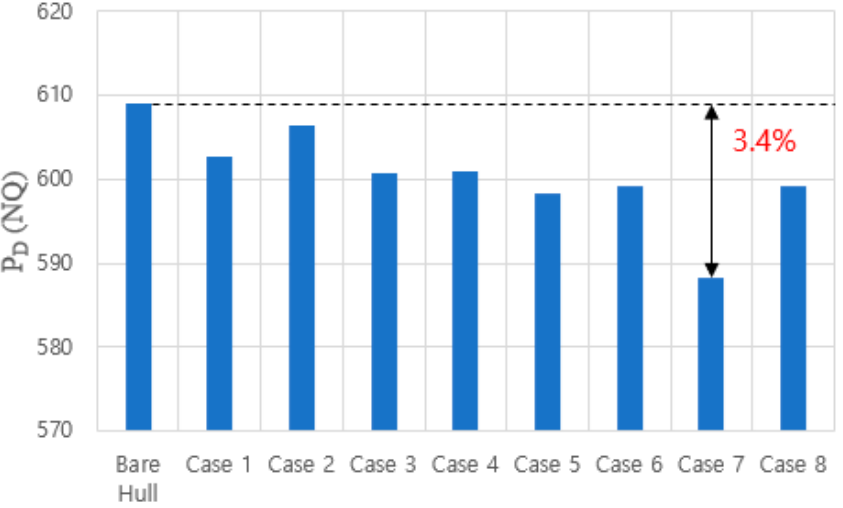
Figure 13. Comparison of the delivered horsepower of each case.